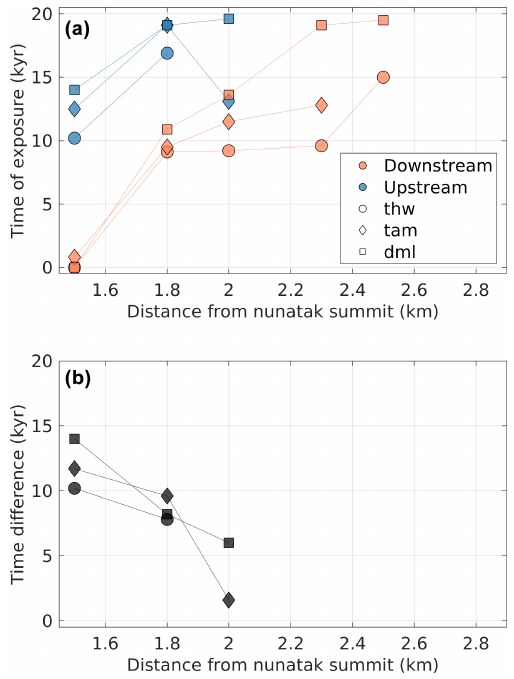
Figure 6. Relationship between distance from the nunatak summit and time of exposure (or stabilisation of the ice surface; model kyr) for nunataks elongated transversely to ice flow under the different thinning scenarios (see Table 2). (a) Time of exposure (in model years) for upstream (blue) and downstream (orange) points for the different thinning experiments: thw (circles), tam (diamonds), and dml (squares). (b) As in panel (a) but showing the time difference between equivalent points for the cases where exposure or stabilisa- tion happens for both up- and downstream points. This figure shows how upstream points lag their respective downstream counterparts (by up to 14kyr) in all thinning